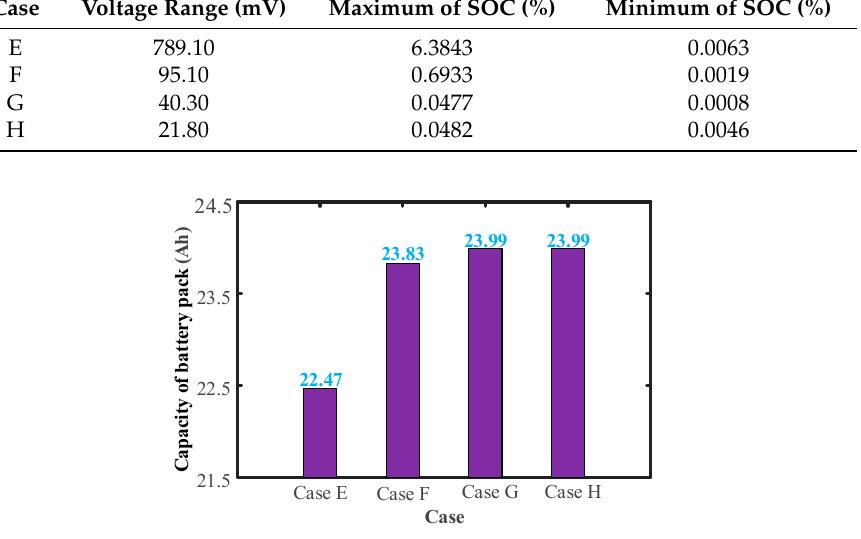
Figure 8. Battery pack capacity after discharging.